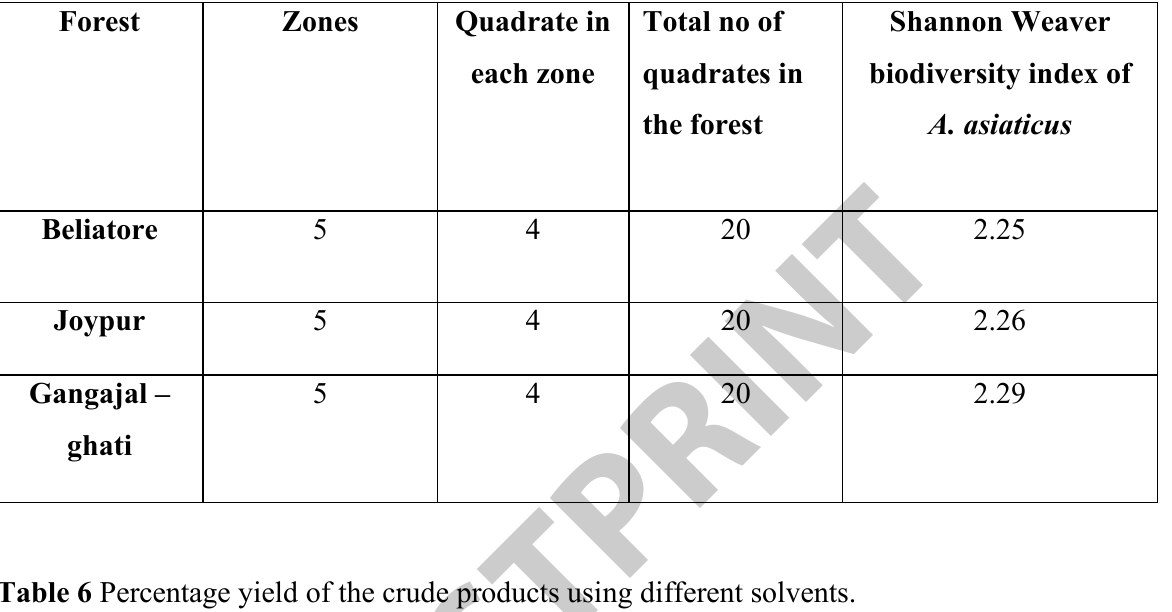
Table 6 Percentage yield of the crude products using different